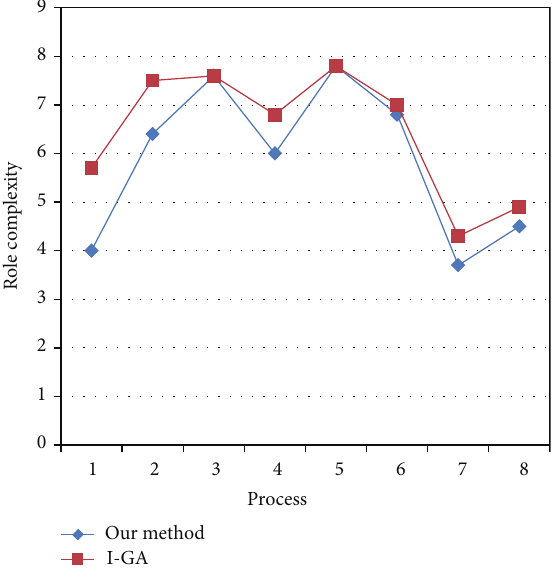
Figure 4: Comparison of role complexity.